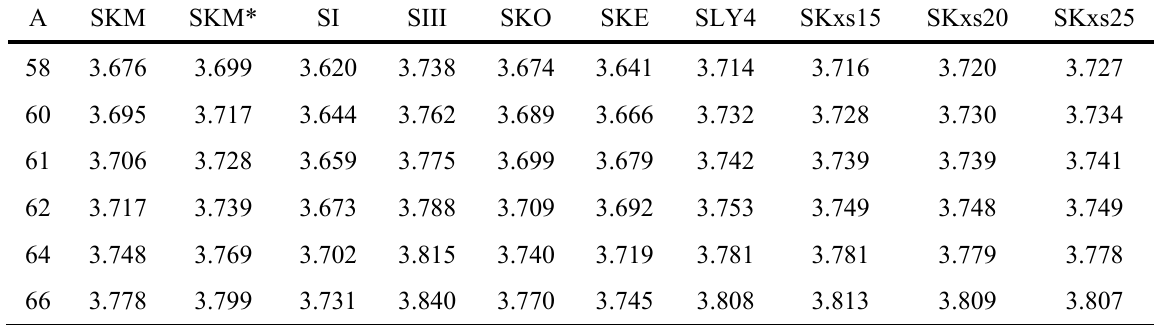
Table 3: Calculated proton rms radii (fm) for the selected Ni-isotopes.